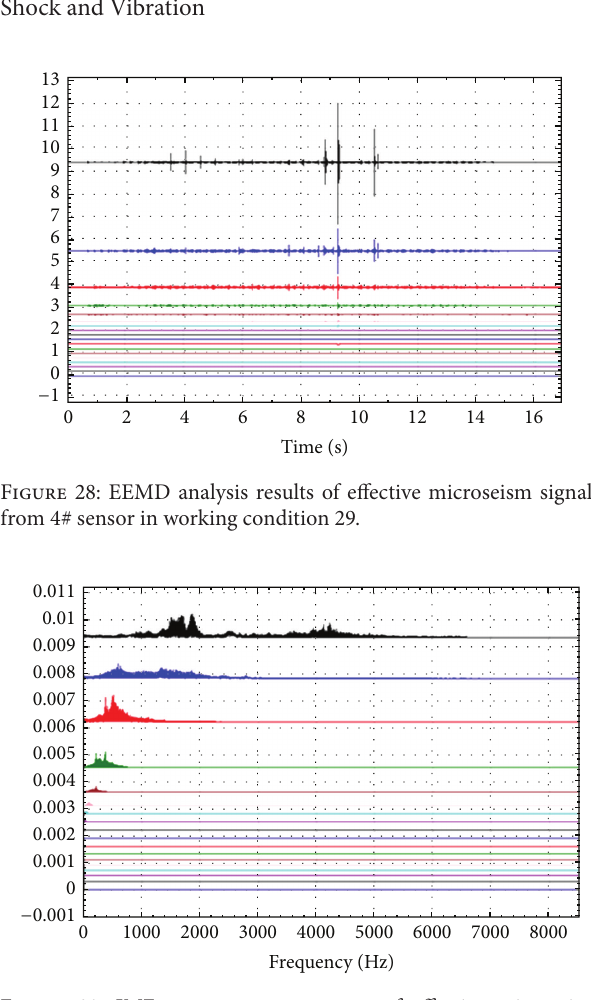
Figure 29: IMF components spectrum of effective microseism signals in working condition 29.